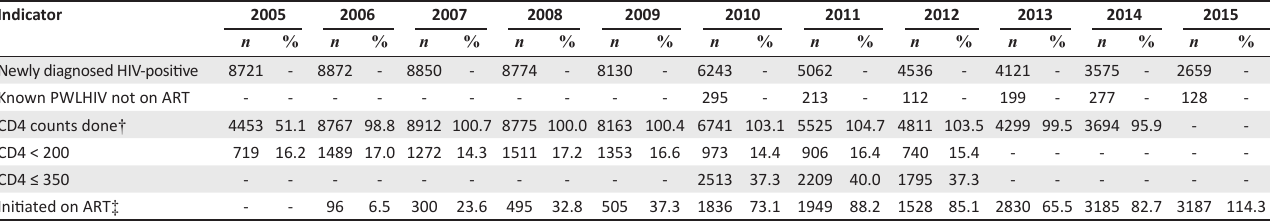
TABLE 3: Pregnant women living with human immunodeficiency virus assessed for antiretroviral therapy eligibility and initiated on treatment at 13 healthcare facilities in Soweto, 2005–2015.